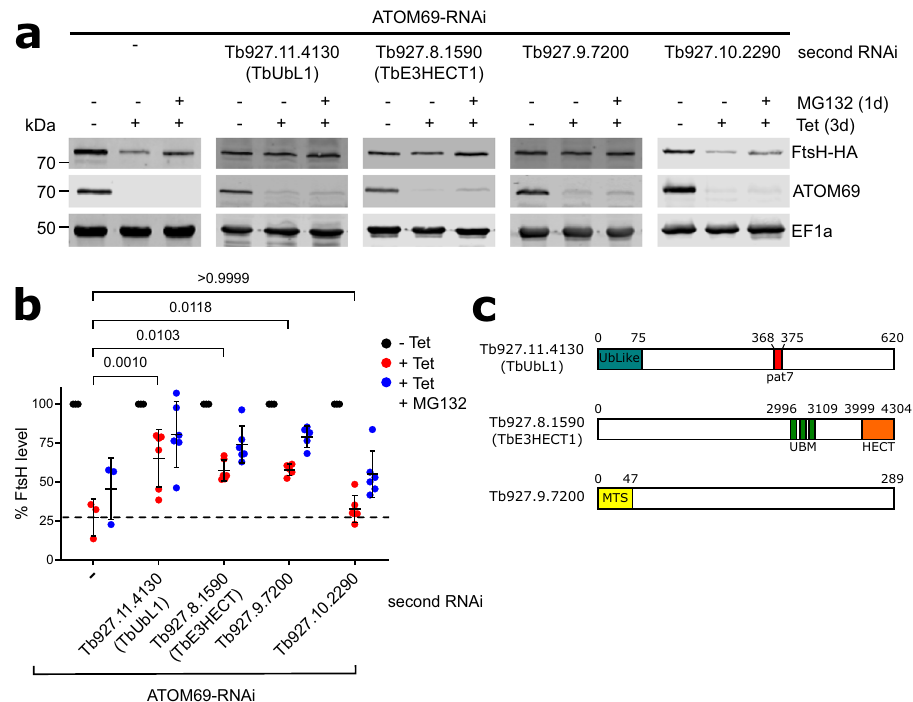
Fig. 3 Three recruited proteins have a role in mitochondrial quality control (MQC). a Immunoblots depicting the change in abundance of a 3x HA-tagged model substrate FtsH (FtsH-HA) in whole cells. RNAi-mediated ablation of atypical translocase of the outer membrane 69 (ATOM69) by tetracycline ( − / + tet) was either performed alone (left panel), or in combination with RNAi-mediated ablation of each of the four candidate proteins (right panels), in the absence and presence of MG132 (1d, 500 nM). 2 × 10 6 cells were loaded per lane. elongation factor 1a (EF1a) is used as a loading control. b Densitometric quanti fi cation of the immunoblot signals of FtsH-HA in the RNAi cell lines shown in a . The signal in the uninduced RNAi cell lines (-Tet) was set to 100%. The level of FtsH-HA for each sample was normalised to its respective EF1a signal. Data are presented as mean values with error bars corresponding to the standard deviation of six independent biological replicates, except for the ATOM69-RNAi cell where three replicates were used. Statistical analysis was performed using a one-way ANOVA followed by a Bonferroni posthoc test to allow for multiple comparisons. The p values calculated are as indicated in the graph. c Predicted domain structure of the three candidate proteins that contribute to the MQC pathway. Tb927.11.4130, termed ubiquitin-like protein 1 (TbUbL1), contains an Ub-Like domain (blue) and a Pat7 monopartite NLS sequence (red). Tb927.8.1590, termed TbE3HECT1, contains three ubiquitin-binding motifs (green) and an E3 ligase C-terminal HECT domain (orange). Tb927.9.7200 contains a predicted N-terminal mitochondrial targeting signal (yellow). Source data are provided as a Source Data fi